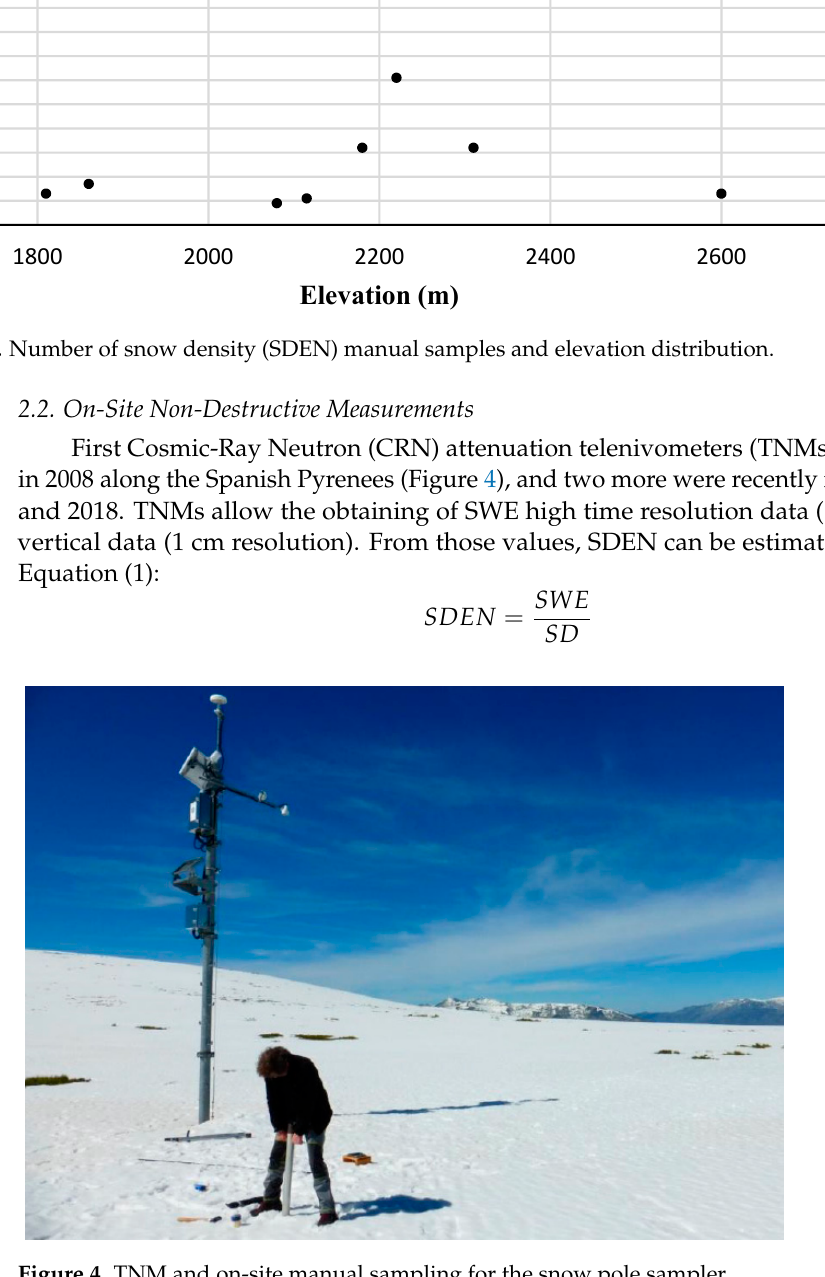
Figure 3. Number of snow density (SDEN) manual samples and elevation distribution.